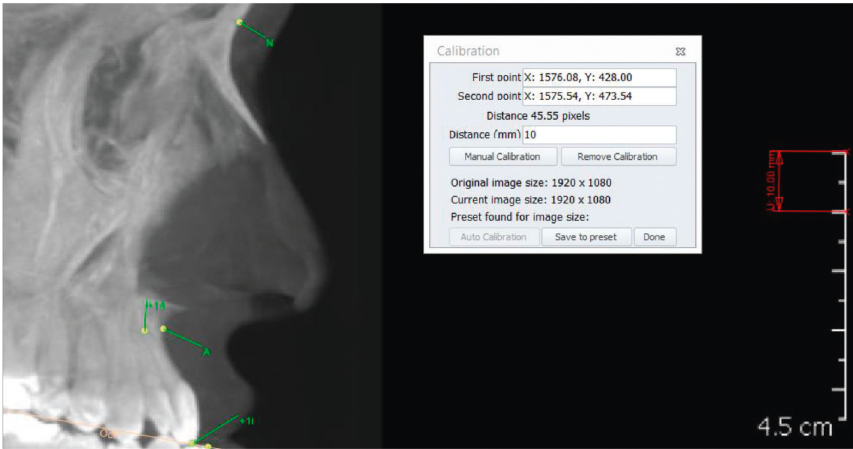
Figure 2: Calibrating the cephalometric image using AudaxCeph ™ .